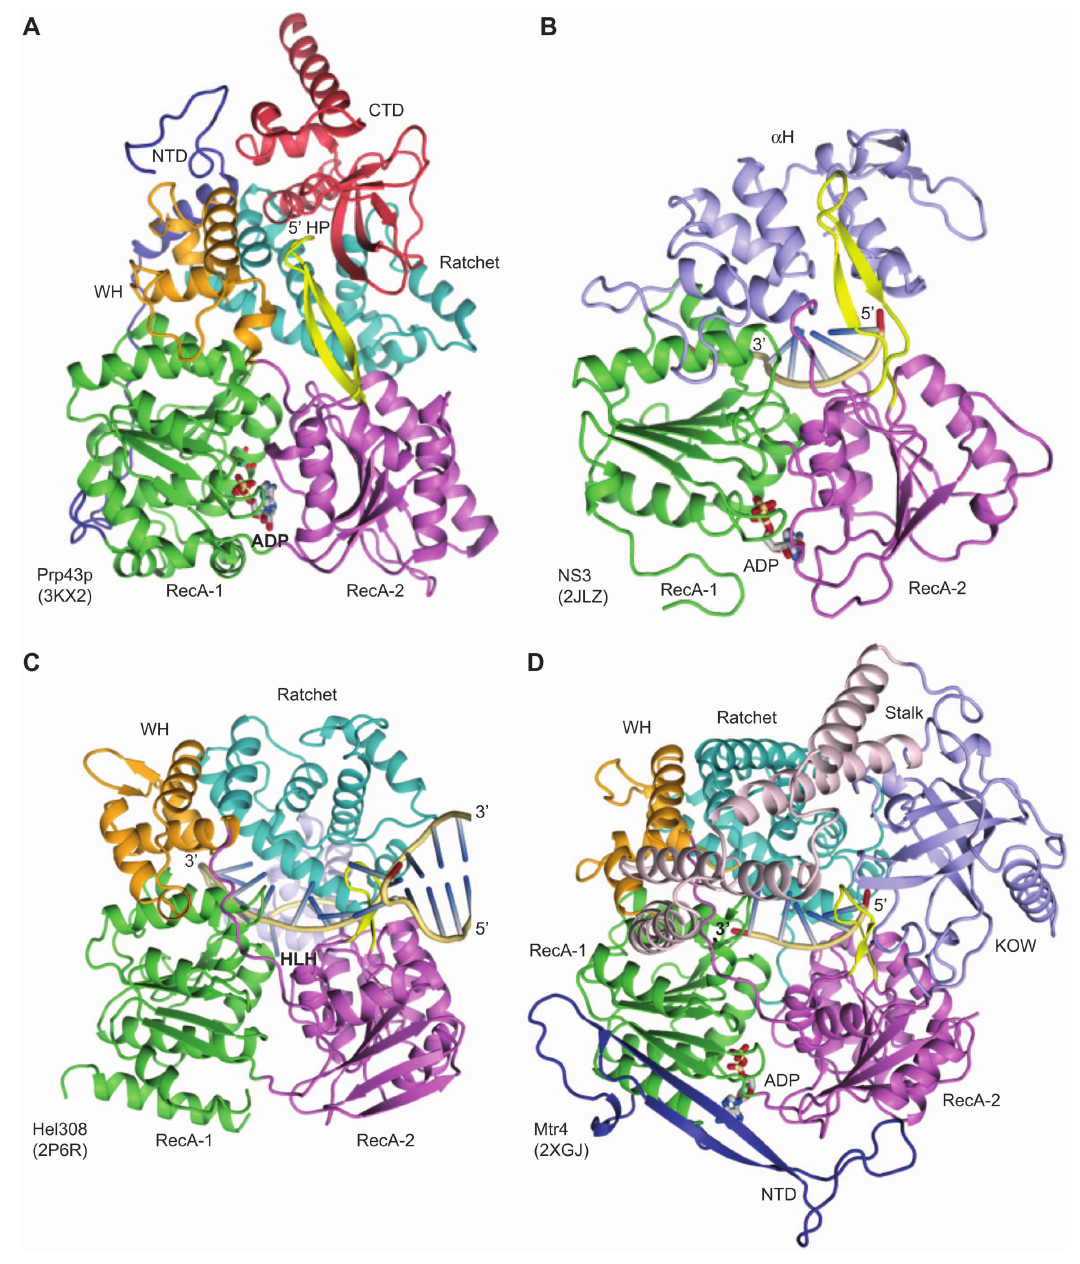
Figure 3 Structural homology between DEAH/RHA helicases and other SF2 families. (A) Structure of Prp43p-ADP (RCSB entry 3KX2). (B) Flavivirus NS3 helicase bound to ADP and RNA (RCSB entry 2JLZ). (C)